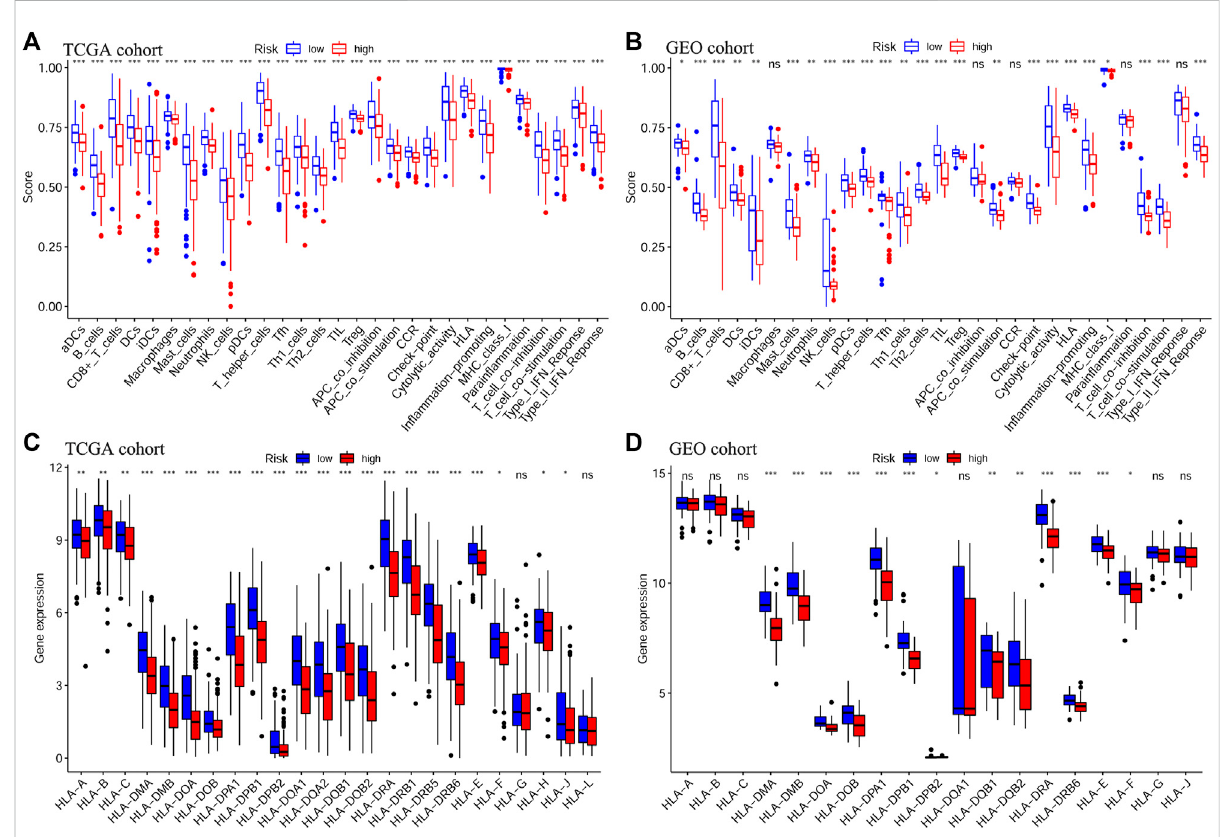
FIGURE 6 Analyses of immune cells and immune functions of the prognostic signature. Evaluation of in fi ltrating scores of 16 immune cells and activity of 13 immune-related pathways in different risk groups via ssGSEA according to TCGA cohort (A) and GEO cohort (B) . Differentially expressed analysis of 24 HLA genes based on TCGA cohort (C) and GEO cohort (D) . The p values were showed as: * p < 0.05; ** p < 0.01; *** p < 0.001. ssGSEA: single- sampleGeneSet Enrichment Analysis,TCGA, TheCancerGenomeAtlas,